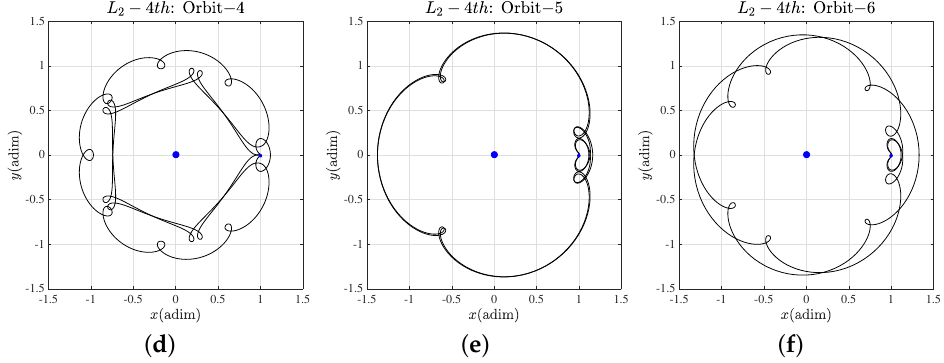
Figure 16. Example RTPOs passing through the L 2 region in the Sun–Jupiter system. ( a ) Orbit-1: initials generated by the second intersection of the trajectory with the x -axis (see Figure 14b). ( b ) Orbit- 2 and ( c ) Orbit-3: initials generated by the third intersection of the trajectory with the x -axis (see Figure 14c). ( d ) Orbit-4, ( e ) Orbit-5 and ( f ) Orbit-6: initials generated by the fourth intersection of the trajectory with the x -axis (see Figure 14d). The larger and the smaller blue dots represent the positions of P 1 and P 2 ,